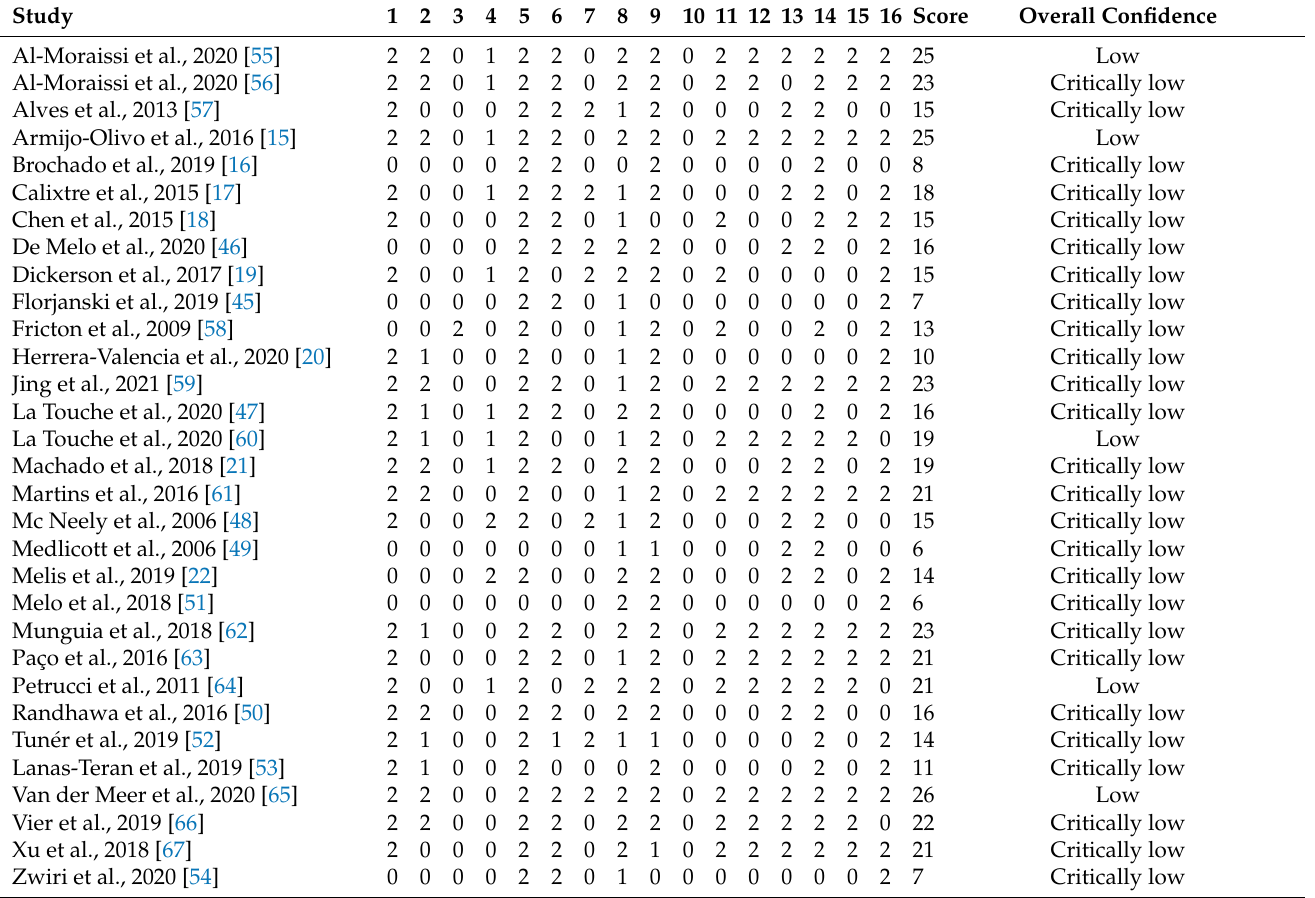
Table 3. Quality assessment scores and resultant reliability statistics (AMSTAR